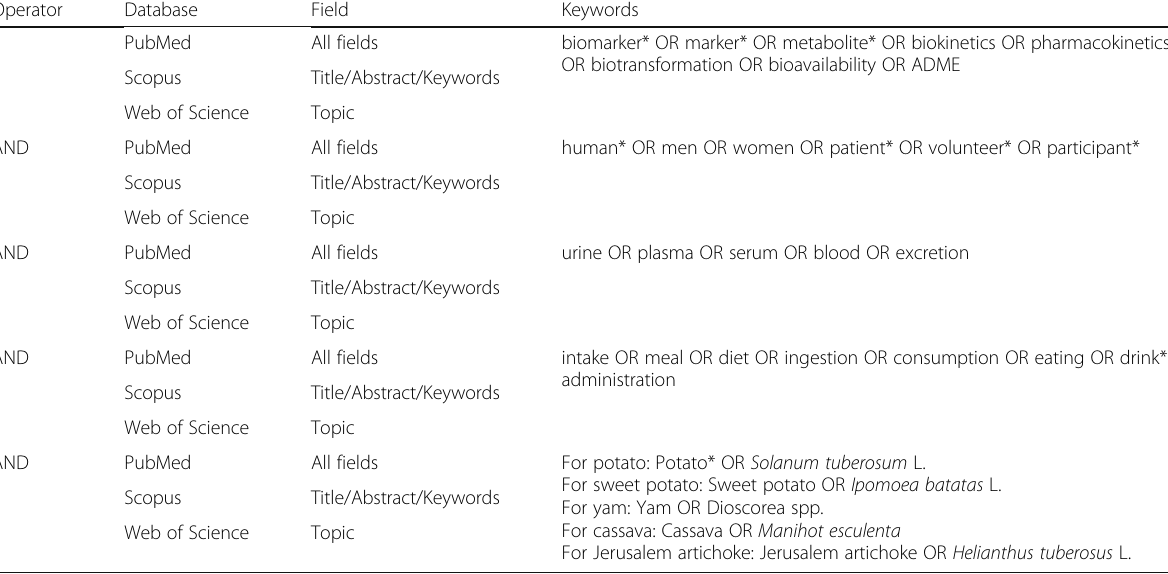
Table 1 Structured literature search